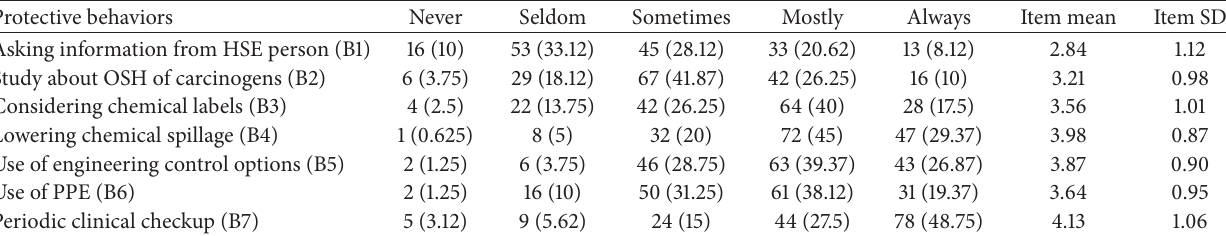
Table 3: A Summary of protective behaviors frequencies among participants ( 𝑛 = 161 ) 𝑁 (%).